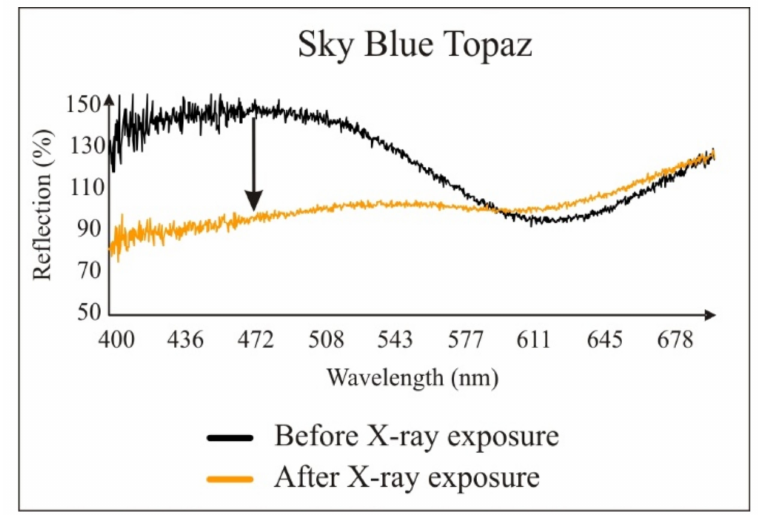
Figure 10. Visible light reflection spectra of the Sky Blue topaz before and after X-ray exposure. Reflection peaks in the blue range (455–492 nm) were